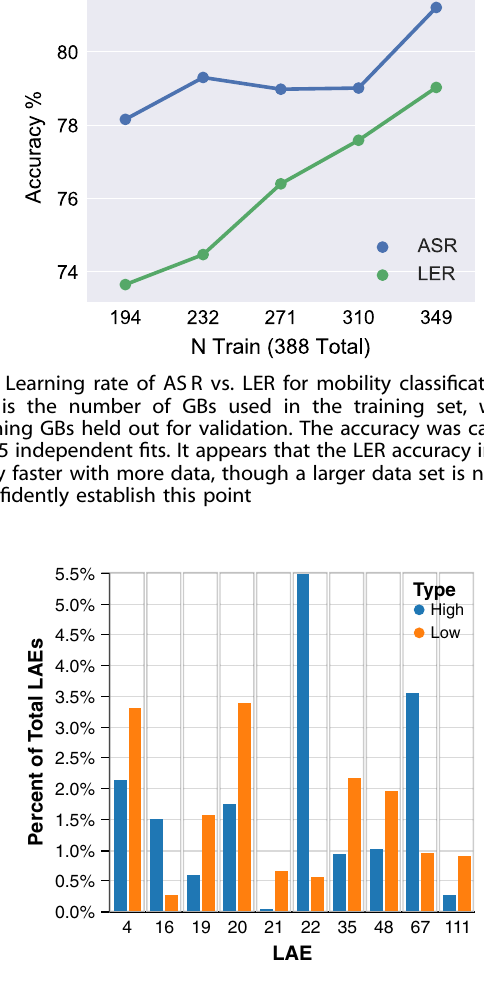
Fig. 4 Histogram comparing the fraction of total LAEs for high and low GB energy. The 15 highest-energy GBs are compared against the 15 lowest-energy GBs using the 10 most-important LAEs for energy prediction. There are clear differences between the relative abundances of these LAEs in deciding whether a GB will have high or low